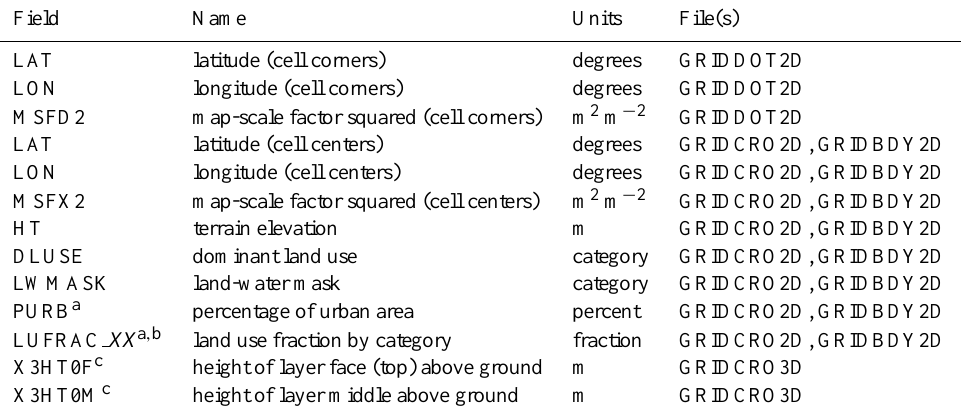
Table 3. Time-invariant fields that are output by